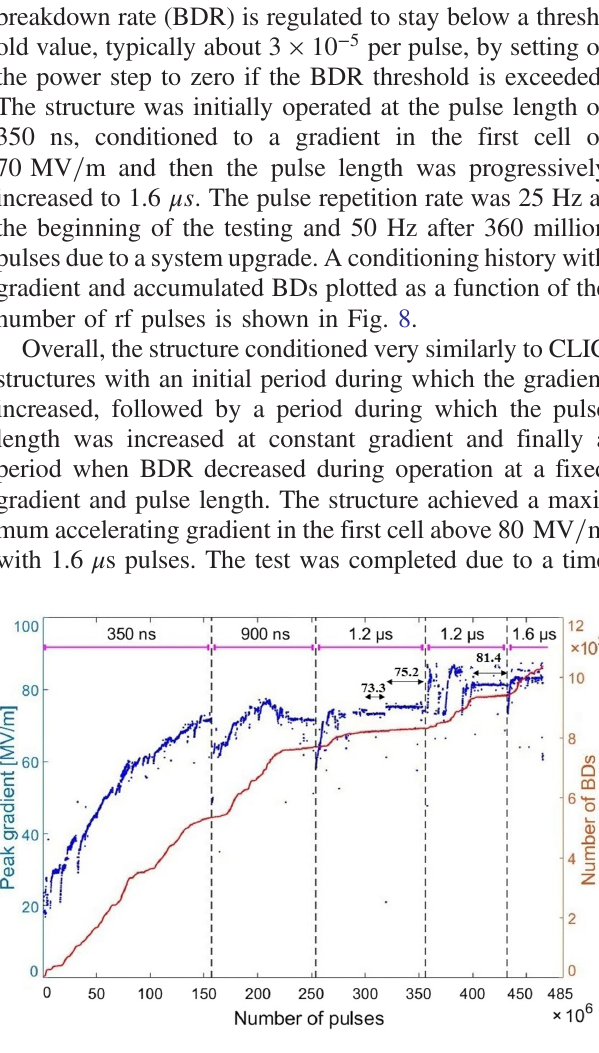
top.FIG. 7. Picture of structure and subsystems in the Sbox test area at